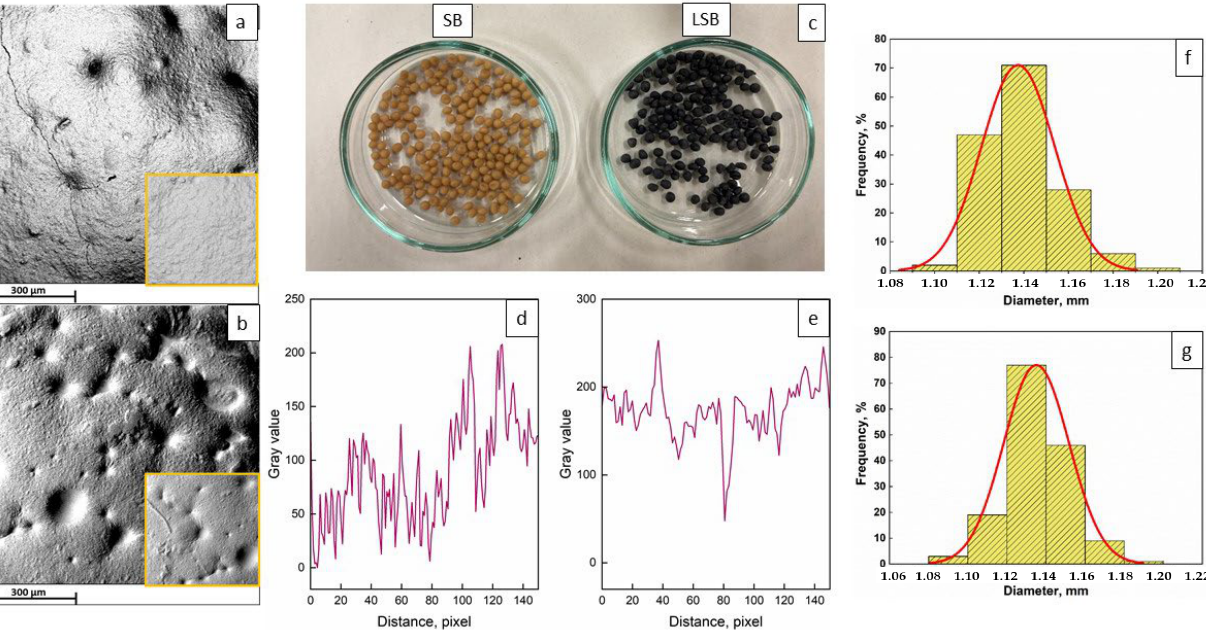
Figure 1. SEM micrographs of SBs ( a ) and LSBs ( b ). Appearance of SB and LSB ( c ). Surface plot profiles for SBs ( d ) and LSBs ( e ). Diameter distributions of SBs ( f ) and LSBs ( g